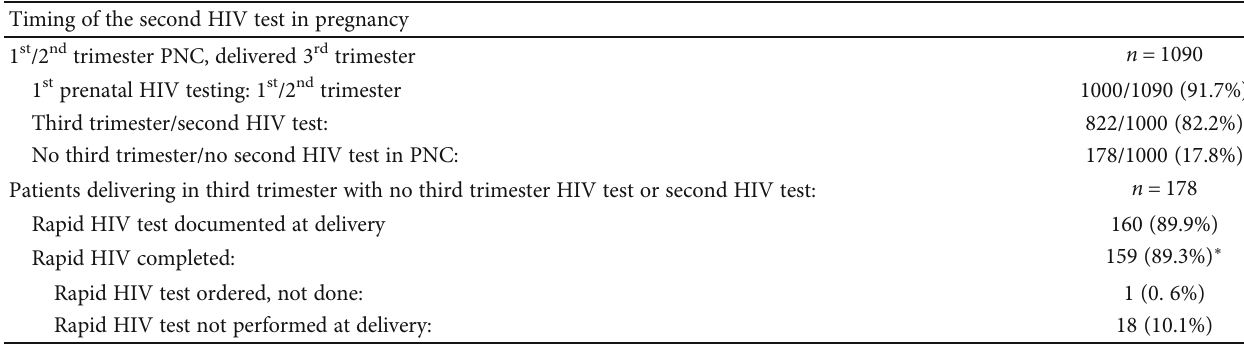
Table 3: Third trimester/second HIV screening test and rapid HIV test at delivery in eligible patients. Repeat HIV screening was identi fi ed in patients who initiated prenatal care in 1 st or 2 nd trimester, and delivered during the third trimester ( ≥ 28 weeks) ( n = 1090 ). In those without repeat HIV screening during prenatal care, we identi fi ed whether rapid HIV testing at delivery was performed. Timing of the second HIV test in